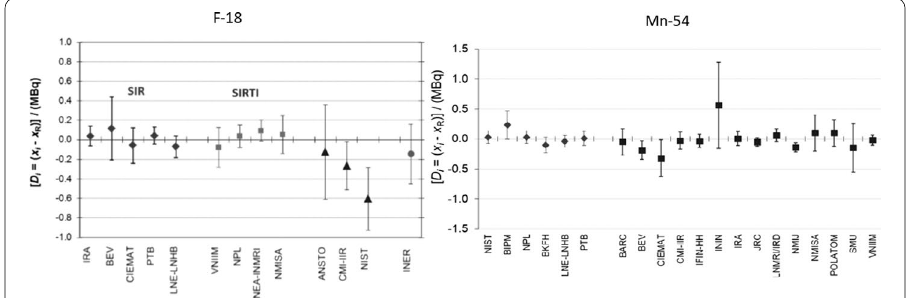
Fig. 1 International comparison for 18 F and 54 Mn for IRA and other NMIs in the Système International de Référence. The vertical axis reports the difference between the reference activity ( X R ) and the measured activity (